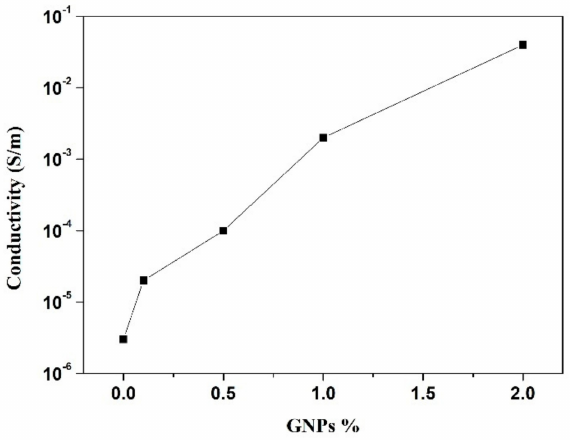
Figure 7. Graphic exhibiting the dependence of conductivity values with GNP percentage.